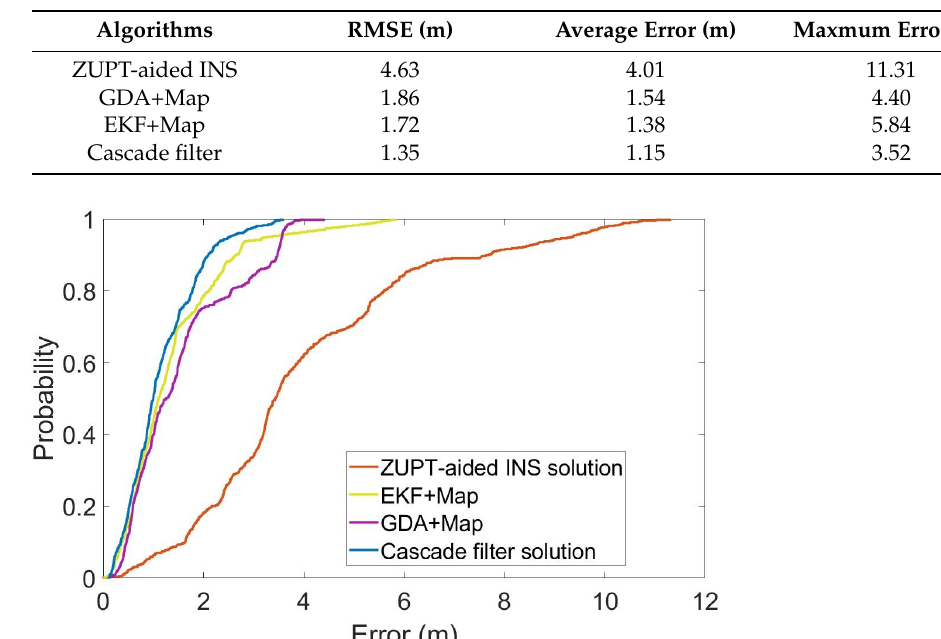
Table 1. Error analysis of 2D positioning.